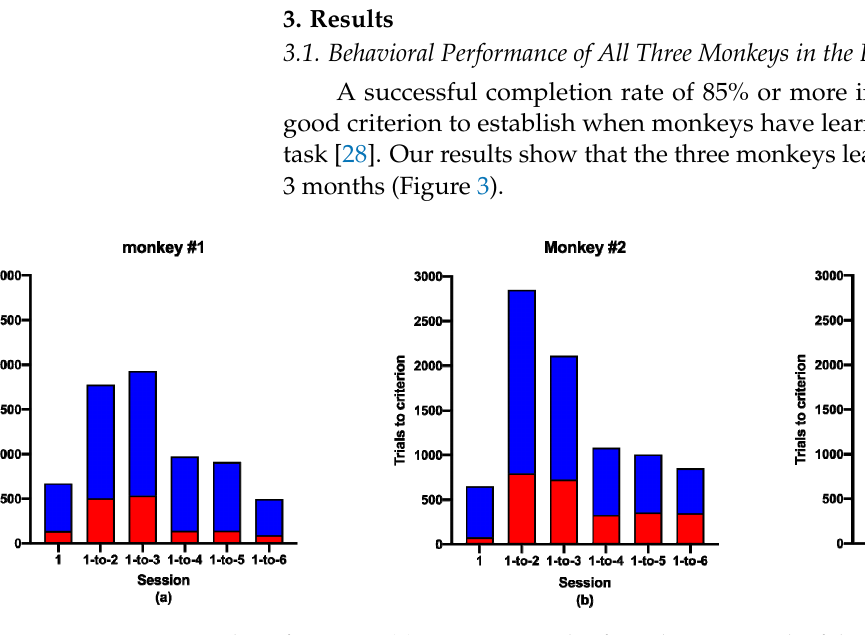
Table 1. Differences in counting task performance for different stages.